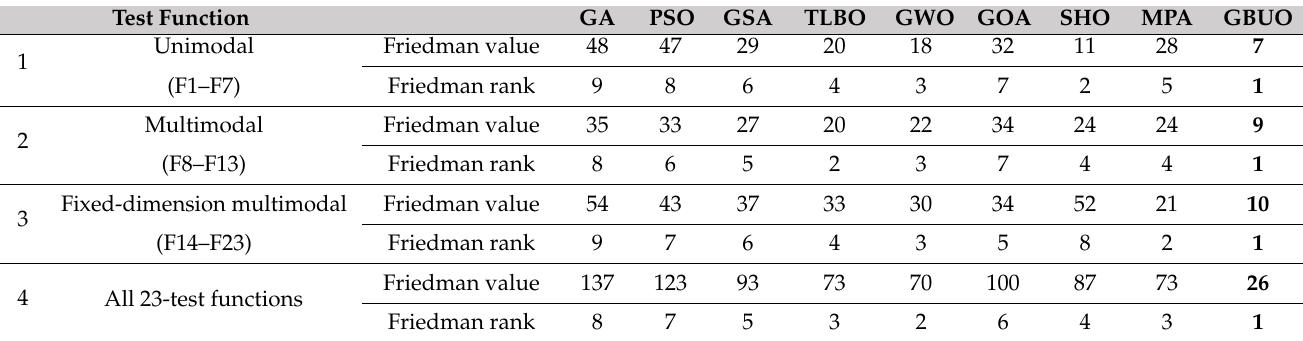
Table 6. Results of the Friedman rank test for evaluate the optimization